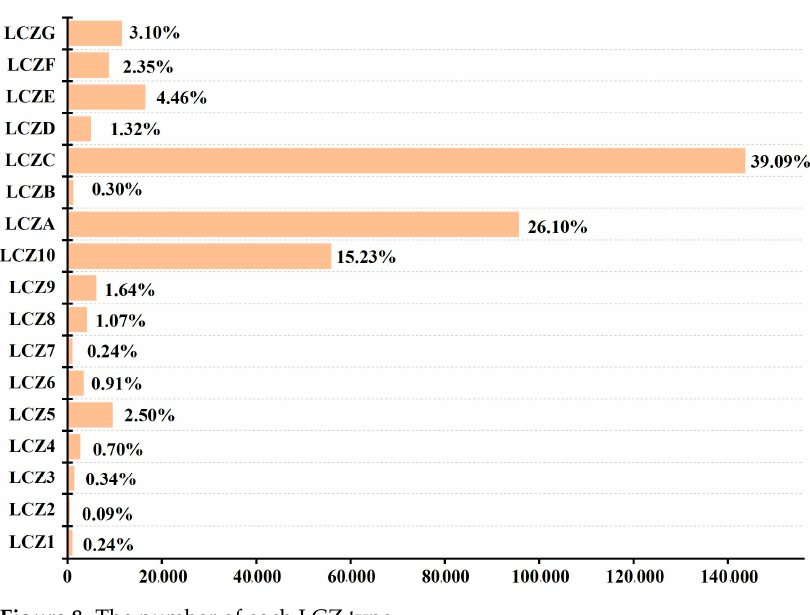
Figure 8. The number of each LCZ type.